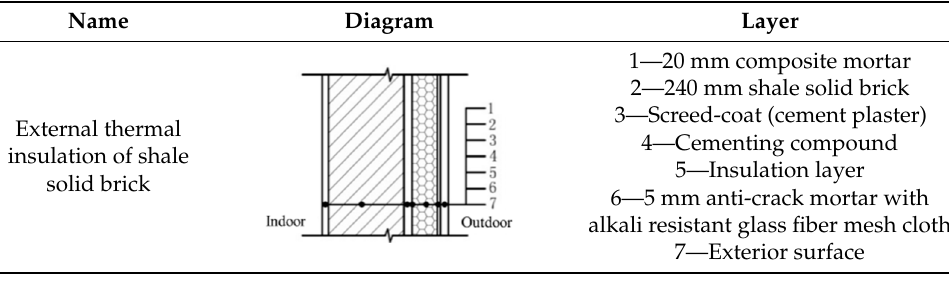
Table 3. Typical thermal insulation structure of exterior wall for rural houses.